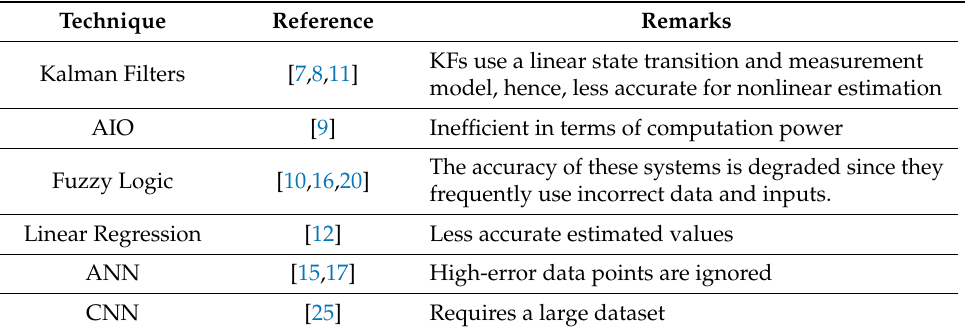
Table 1. FTCS approaches and their